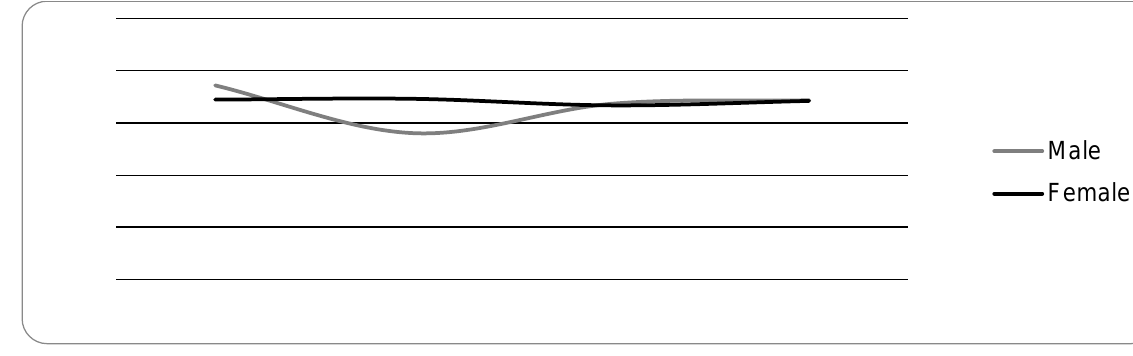
Fig 2: difference in gender about leadership